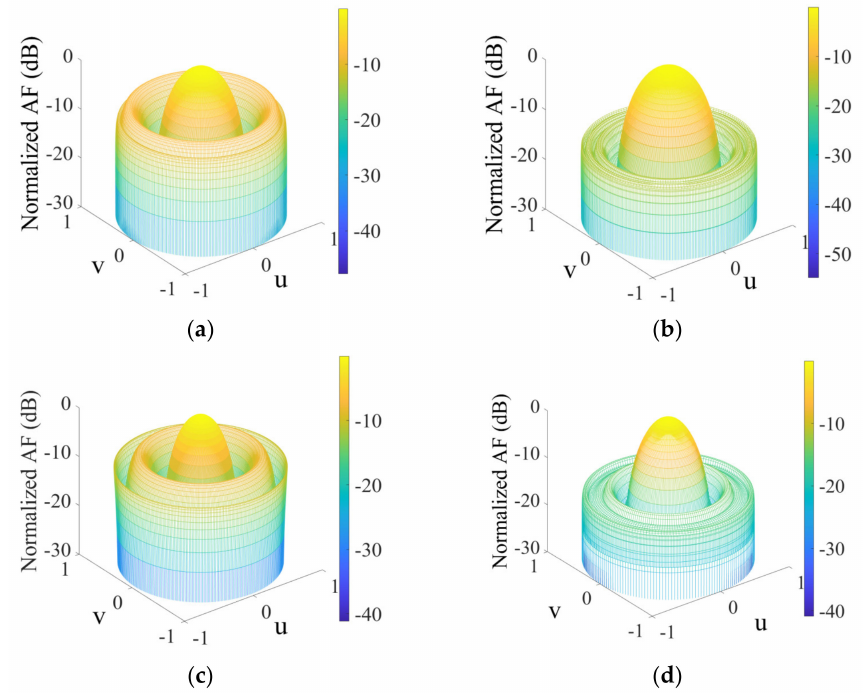
Figure 5. 3D radiation patterns of CAA. ( a ) 8 − element CAA uniform array; ( b ) 8 − element CAA for